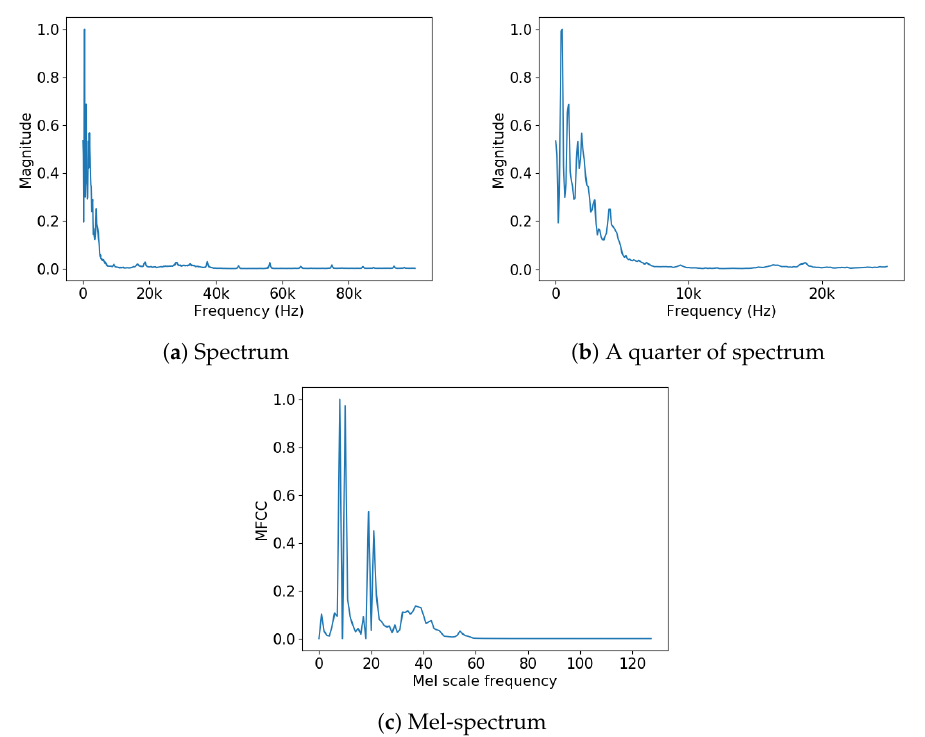
Figure 2. Subfigures ( a , b ) are time-averaged spectrum after STFT and ( c ) is 128-dimensional time-averaged Mel-spectrum after MFCC feature extraction. ( a ) represents a range of 96 kHz, with a resolution of 1025; ( b ) is an expanded view of a quarter of ( a ). Each unit of ( c ) represents one MFCC filter